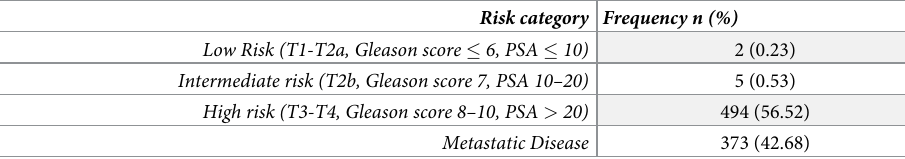
Table 2. ESMO prostate cancer risk